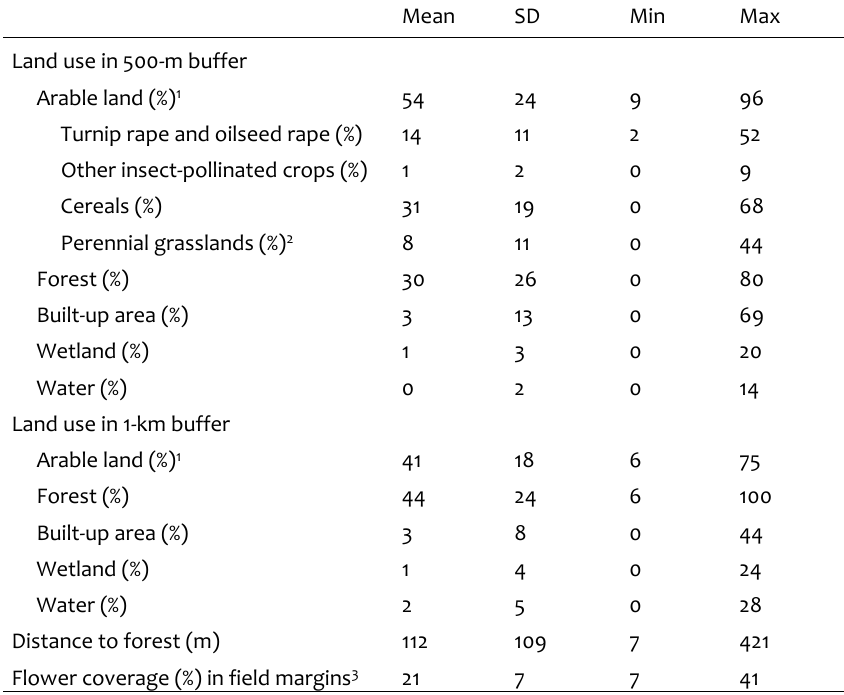
Table 1.Landscape characteristics of the study sites. Percentage cover of land use types were calculated within 500-m and 1-km buffers. Crop types were recorded only within the 500-m buffers during fieldwork. Distance to forest was measured from the sampling location closest to